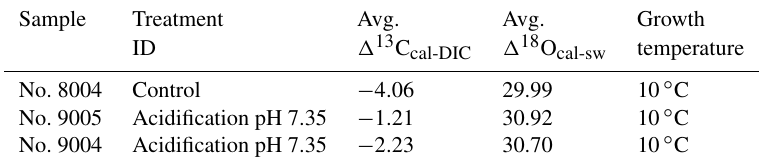
Table 11. Calculated carbon and oxygen fractionation factors for brachiopods based on cultured M. venosa and culture seawater.